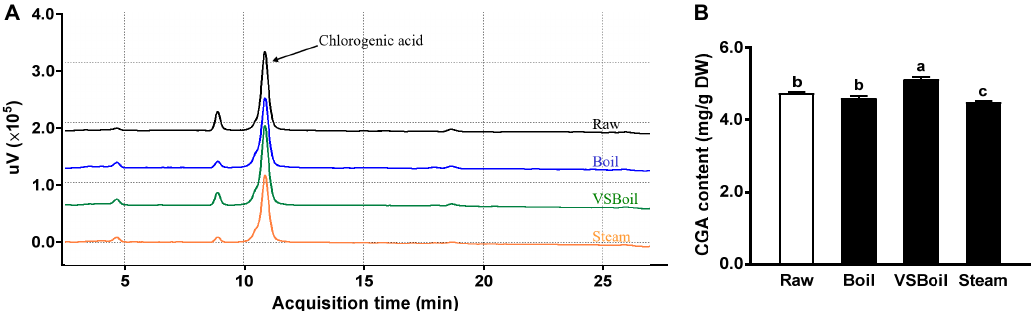
Figure 1. Chlorogenic acid content in PP extracts. ( A ). Representative high-performance liquid chromatography graphs of PP extracts at 320 nm. ( B ). Chlorogenic acid (CGA) content in PP extracts. DW: dry weight; VSBoil: vacuum-seal boiling. a–c means among bars without common letters differ significantly at p < 0.05 (mean ± SEM, n = 3).